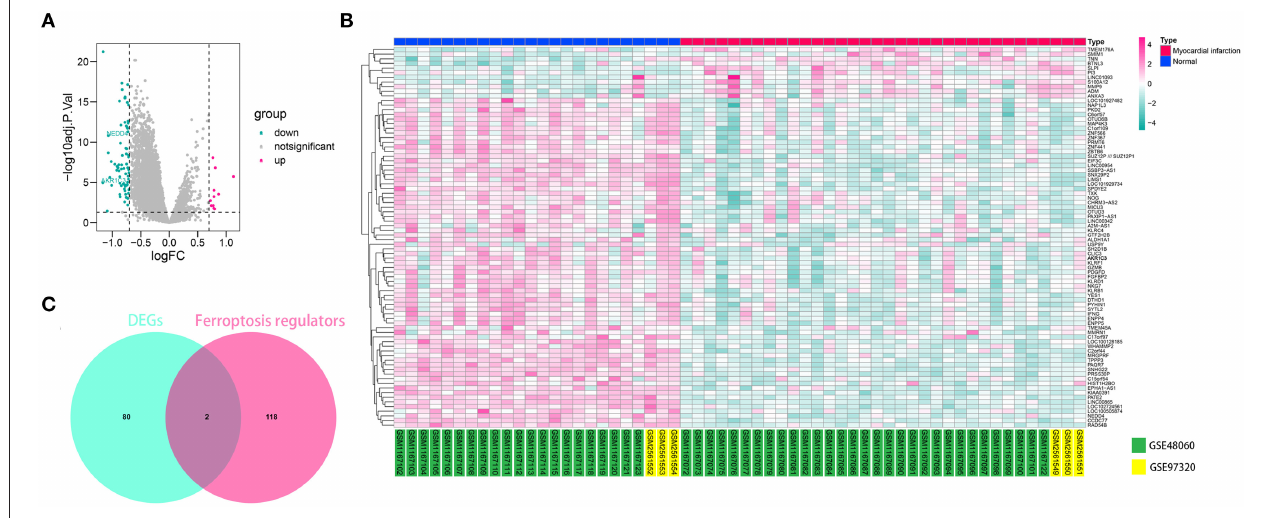
FIGURE 2 | AKR1C3 was differentially expressed in acute myocardial infarction (AMI) samples. (A) Volcano map indicating the 82 differentially expressed genes (DEGs) between normal and AMI samples. (B) Heat map showing the 82 DEGs. (C) Among 120 ferroptosis-related genes, AKR1C3 and NEDD4 were differentially